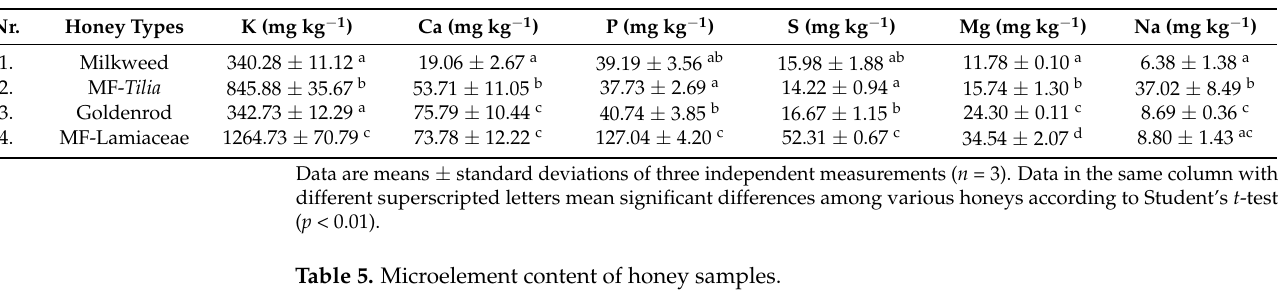
Table 4. Macroelement content of the studied honey samples.